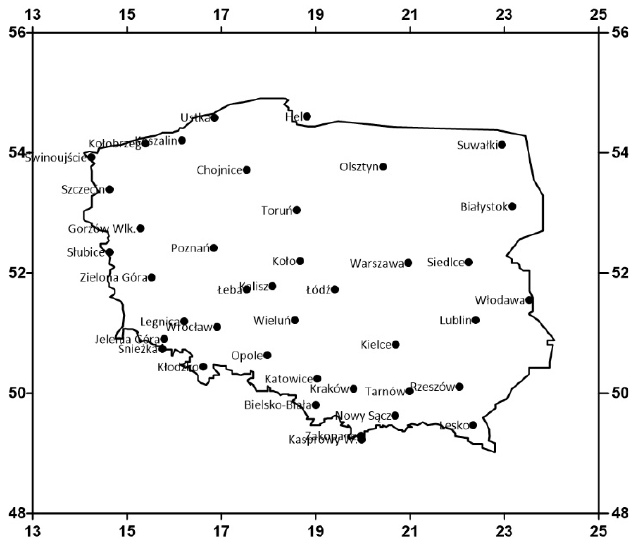
Figure 1. Locations of stations with Tmax data.